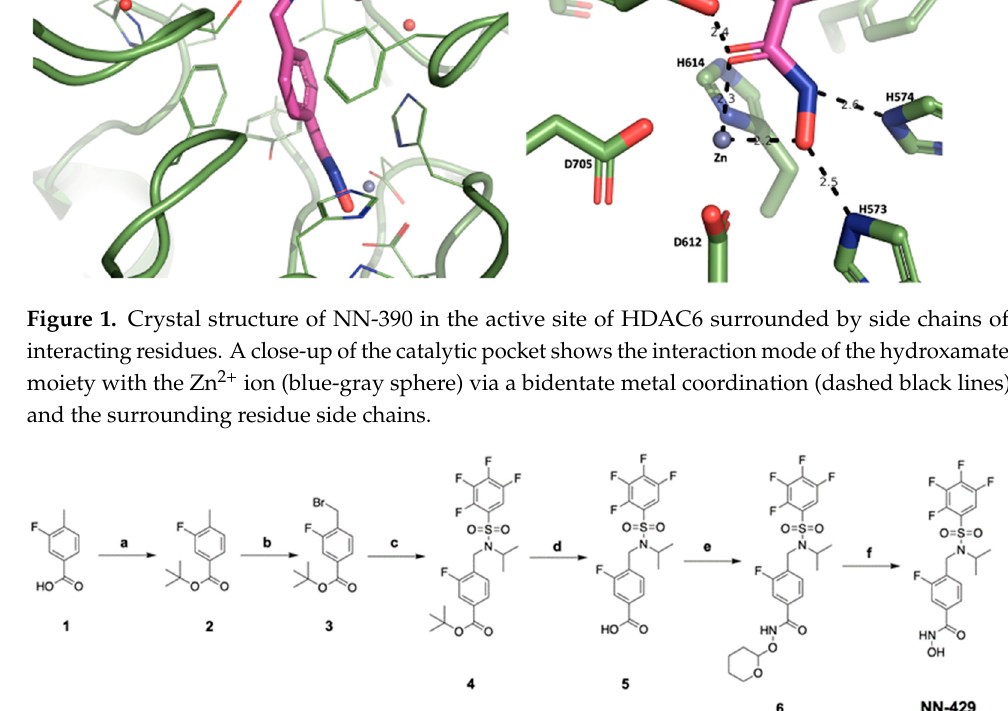
Figure 1. Crystal structure of NN-390 in the active site of HDAC6 surrounded by side chains of interacting residues. A close-up of the catalytic pocket shows the interaction mode of the hydrox- amate moiety with the Zn 2+ ion (blue-gray sphere) via a bidentate metal coordination (dashed black lines) and the surrounding residue side